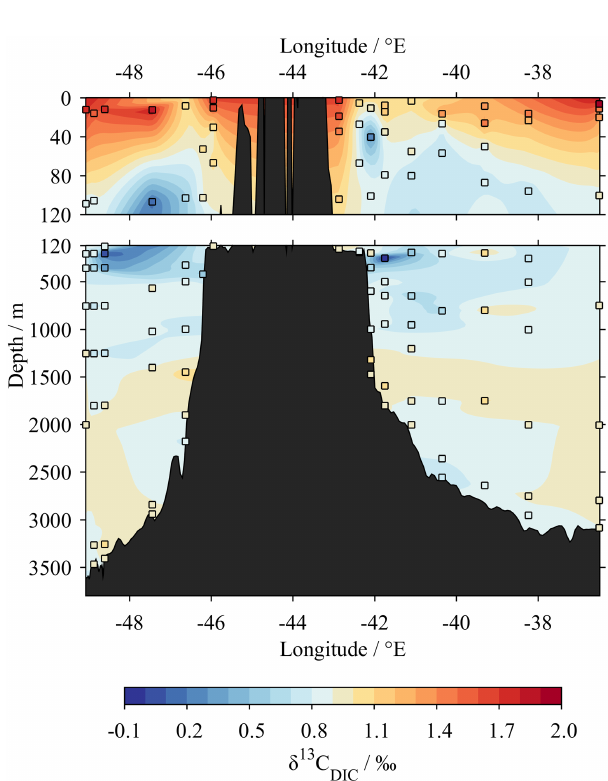
Figure 6. Zonal section of δ 13 C DIC results from this study, from west to east across the subpolar North Atlantic Ocean (blue in Fig. 1). Coloured squares show actual sample locations and δ 13 C DIC values. Vertical dashed lines indicate locations of joints with edges of Figs. 7 and 8. Bathymetry data are from the GEBCO_2014 grid, version 20150318, http://www.gebco.net.